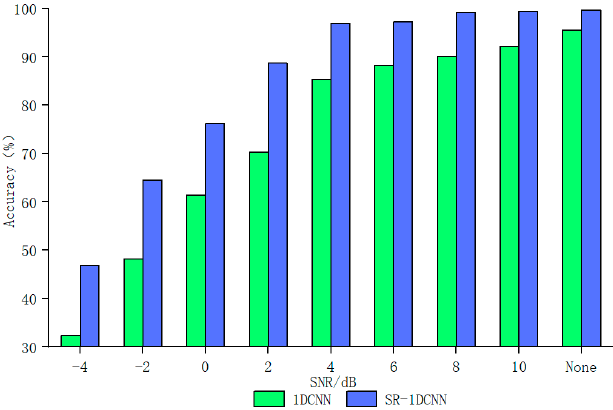
Figure 11. Accuracy of test set under different SNR (test set of CWRU).